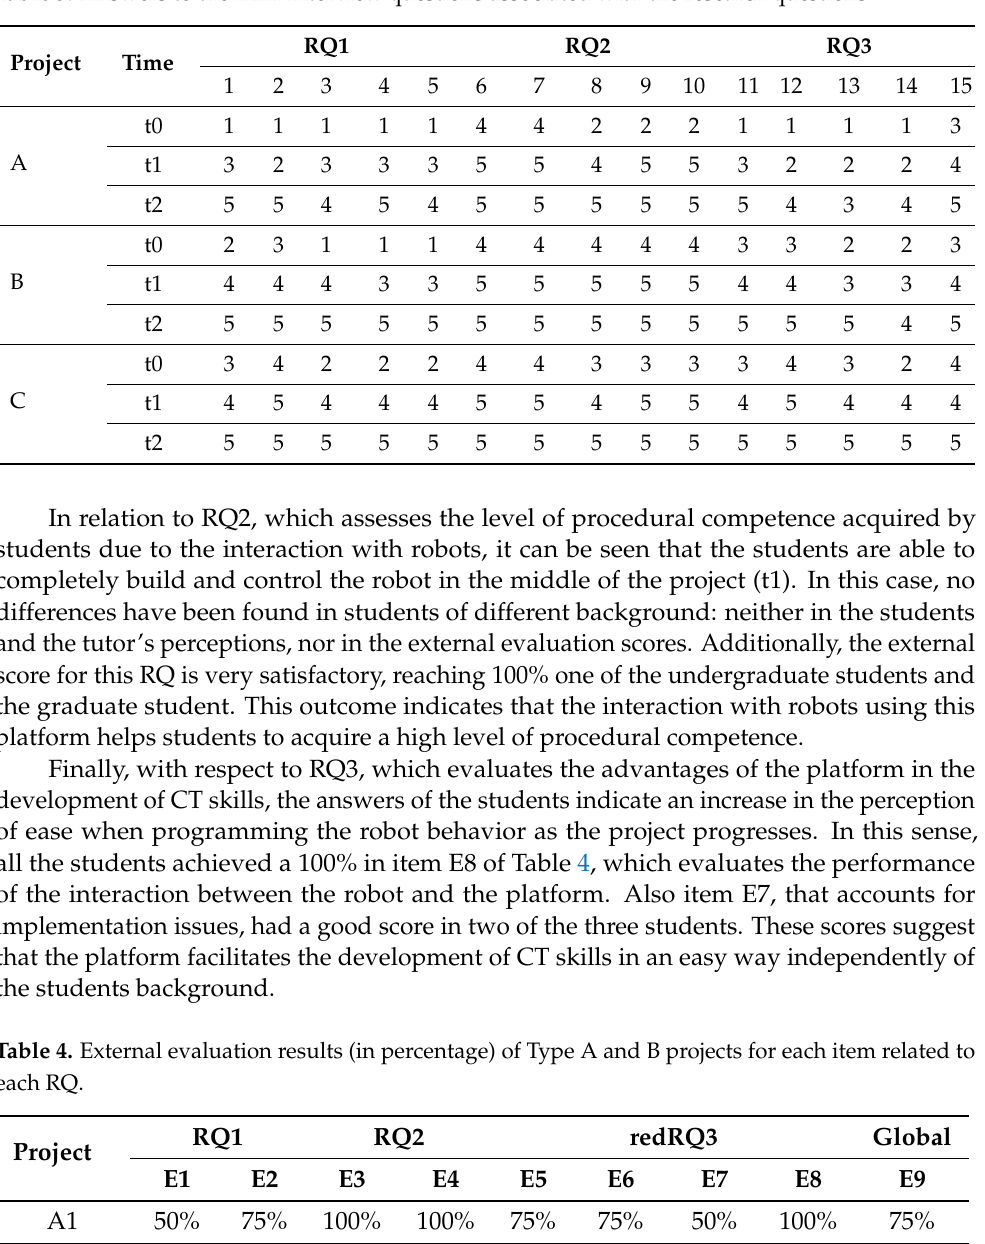
Table 3. Answers to the mini-interview questions associated with the research questions.